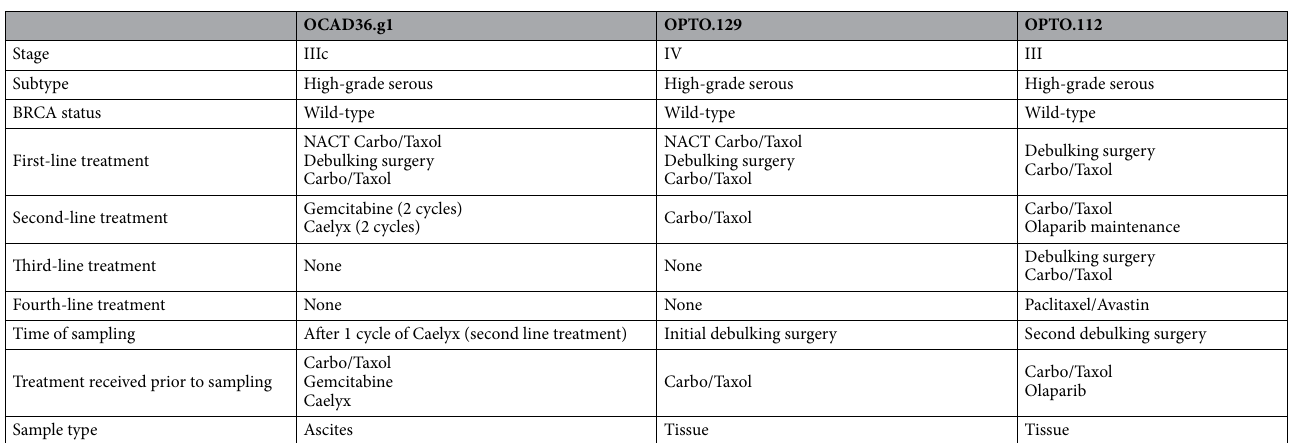
Table 2. Patient profiles for organoid models. NACT neo-adjuvant chemotherapy, carbo carboplatin.